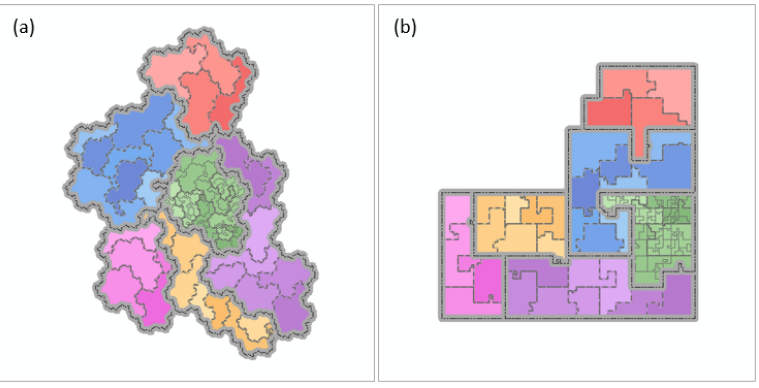
Figure 4. The Gosper map and Hilbert map generated from the same data: ( a ) Gosper map and ( b ) Hilbert map. ( b ) Hilbert